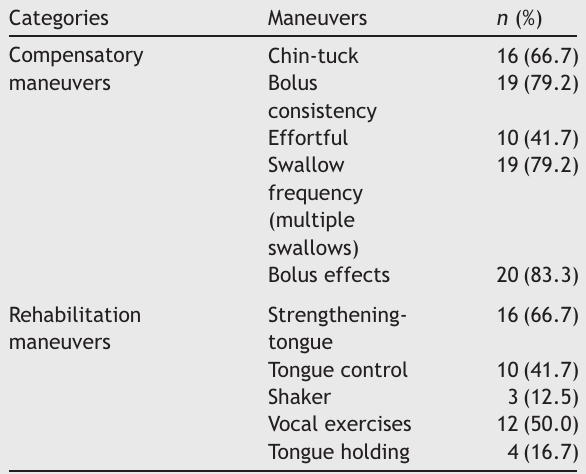
Table 2 Frequency of maneuvers recommended in the swallowing management in a case series of patient with Parkinson’s disease followed in a dysphagia outpatient between 2006 and 2011 ( n =